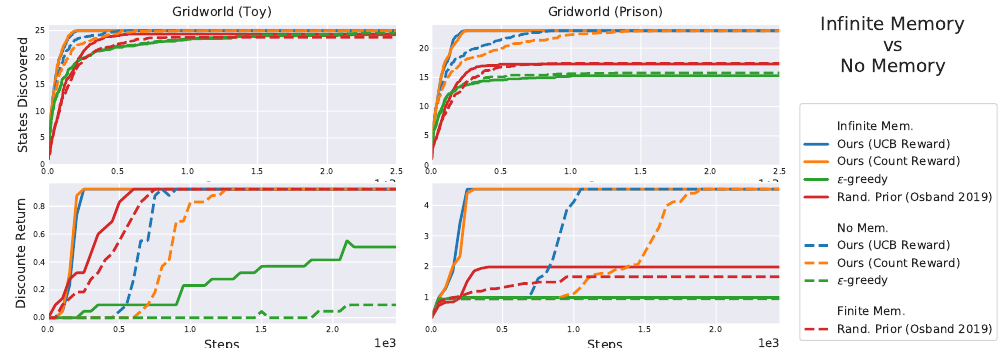
Figure A1. Comparison of the proposed exploration against (cid:101) -greedy and bootstrapped exploration with and without replay memory. Each line denotes the average over 20 seeds. Only exploration based on the visitation value always learns in both domains, i.e., both with and without local optima (distractor rewards), regardless of the memory.